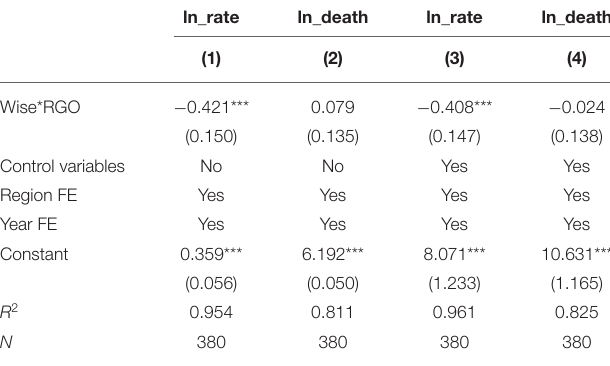
TABLE 10 | Results of different